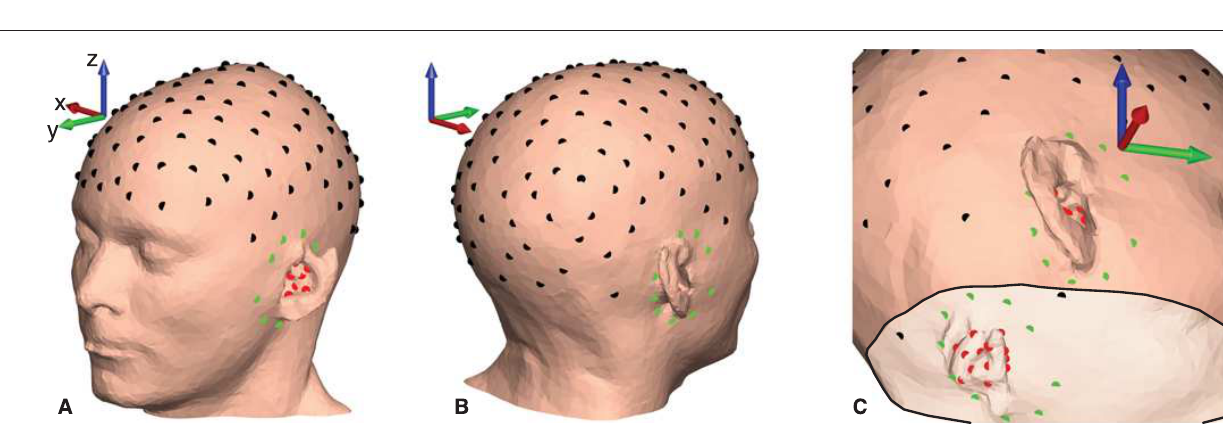
FIGURE 5 | Electrode locations plotted on the scalp mesh grid for subject C. Black dots indicate gelled cap electrodes, green dots indicate dry-contact cEEGrid electrodes, and red dots indicate dry-contact ear-EEG electrodes. (A,B) Electrode locations on the scalp surface. (C) Electrode locations seen from the inside of the scalp